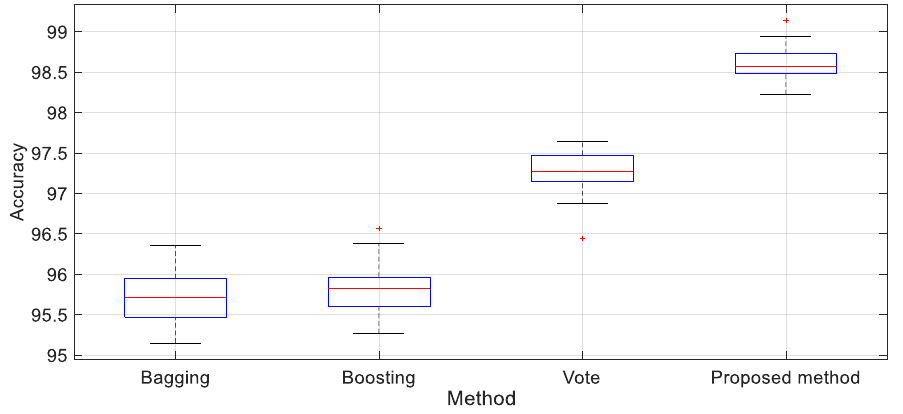
Figure 11. Box diagram of detection accuracy.